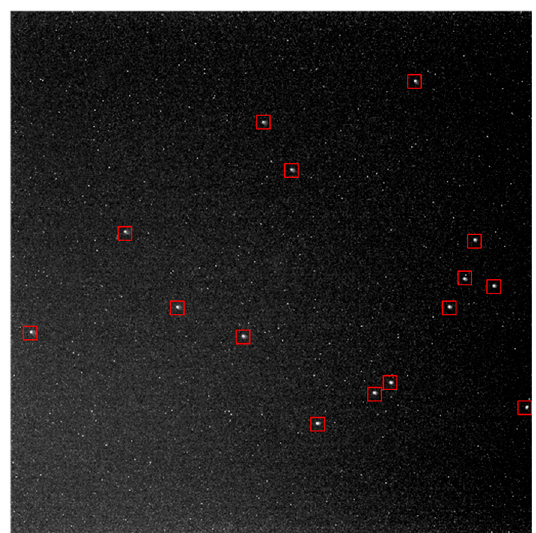
Figure 16. Star image created by the dynamic star simulator.